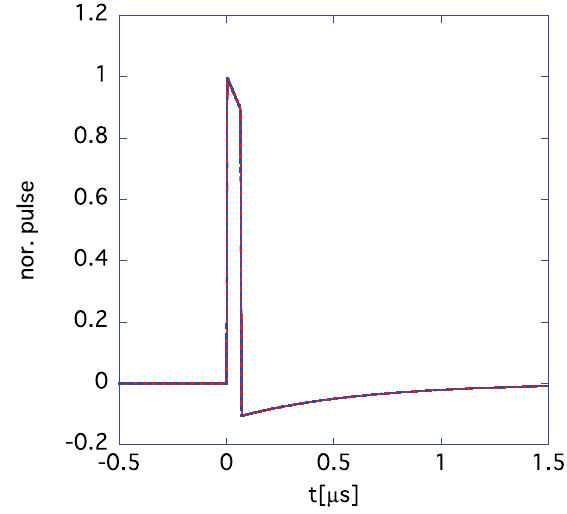
FIG. 19. Normalized results of V 2 ð t Þ obtained by analytically inverse Fourier transforming the purple and green lines in Fig. 18. The red line is obtained by Eq. (58), while the blue line is obtained by Eq. (61), neglecting the contribution from C